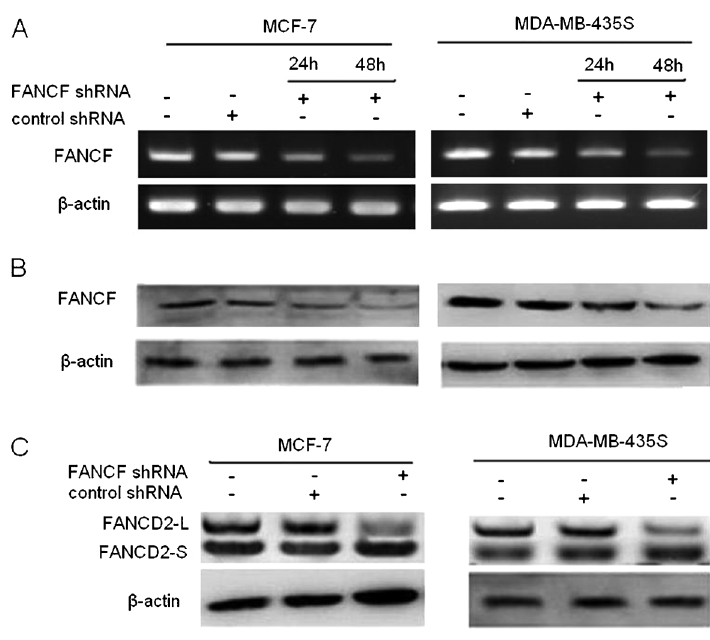
blots. (FANCD2-L: mono-ubiquitinated; FANCD2-S: